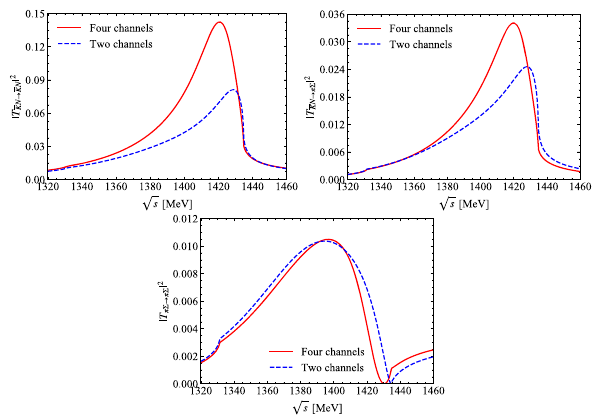
Fig. 3 Modulus square of ¯ K N → ¯ K N , ¯ K N → π(cid:4) and π(cid:4) → π(cid:4) amplitudes